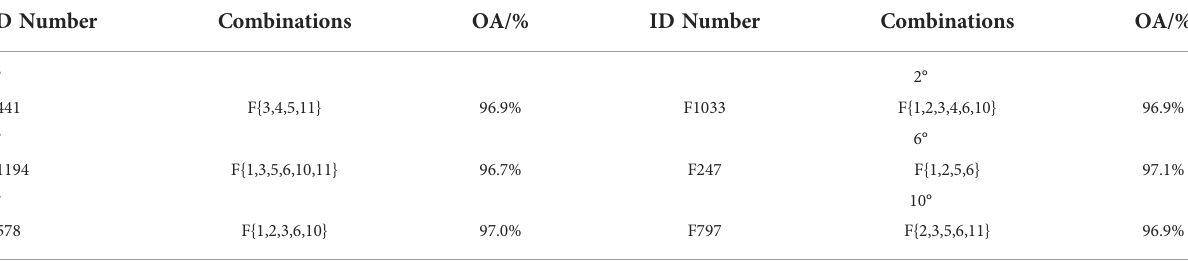
TABLE 4 Overall accuracy of the optimal feature combination at each small incidence angle using the optimal classi fi er (the KNN method with Euclidean distance and k equal to 11). ID